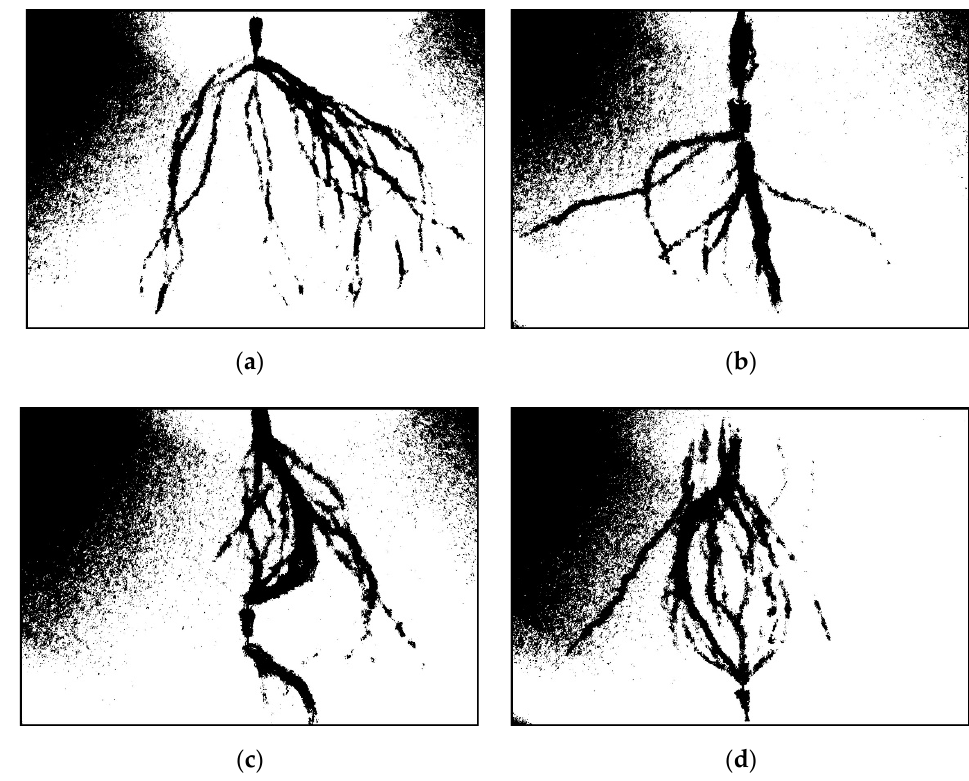
Figure 10. Conversion of tracking image from color mode to gray ‐ level by directly compared with threshold. The images in this figure are in accordance with the images in Figure 7. In ( a ), the particle is located at 19 mm. In ( b ), the particle is located at 71 mm. In ( c ), the particle is located at 123 mm. And in ( d ), the particle is located at 175 mm from HV electrode.